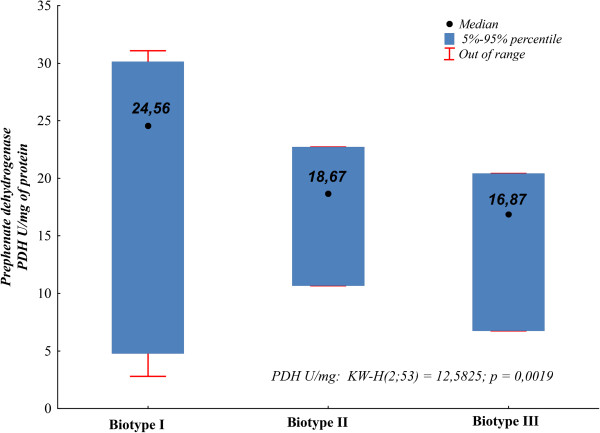
Graphical interpretation of the Kruskal-Wallis test, p = 0.0019. Comparison of median values of prephenate dehydrogenase (PDH) in biotypes (I-III).